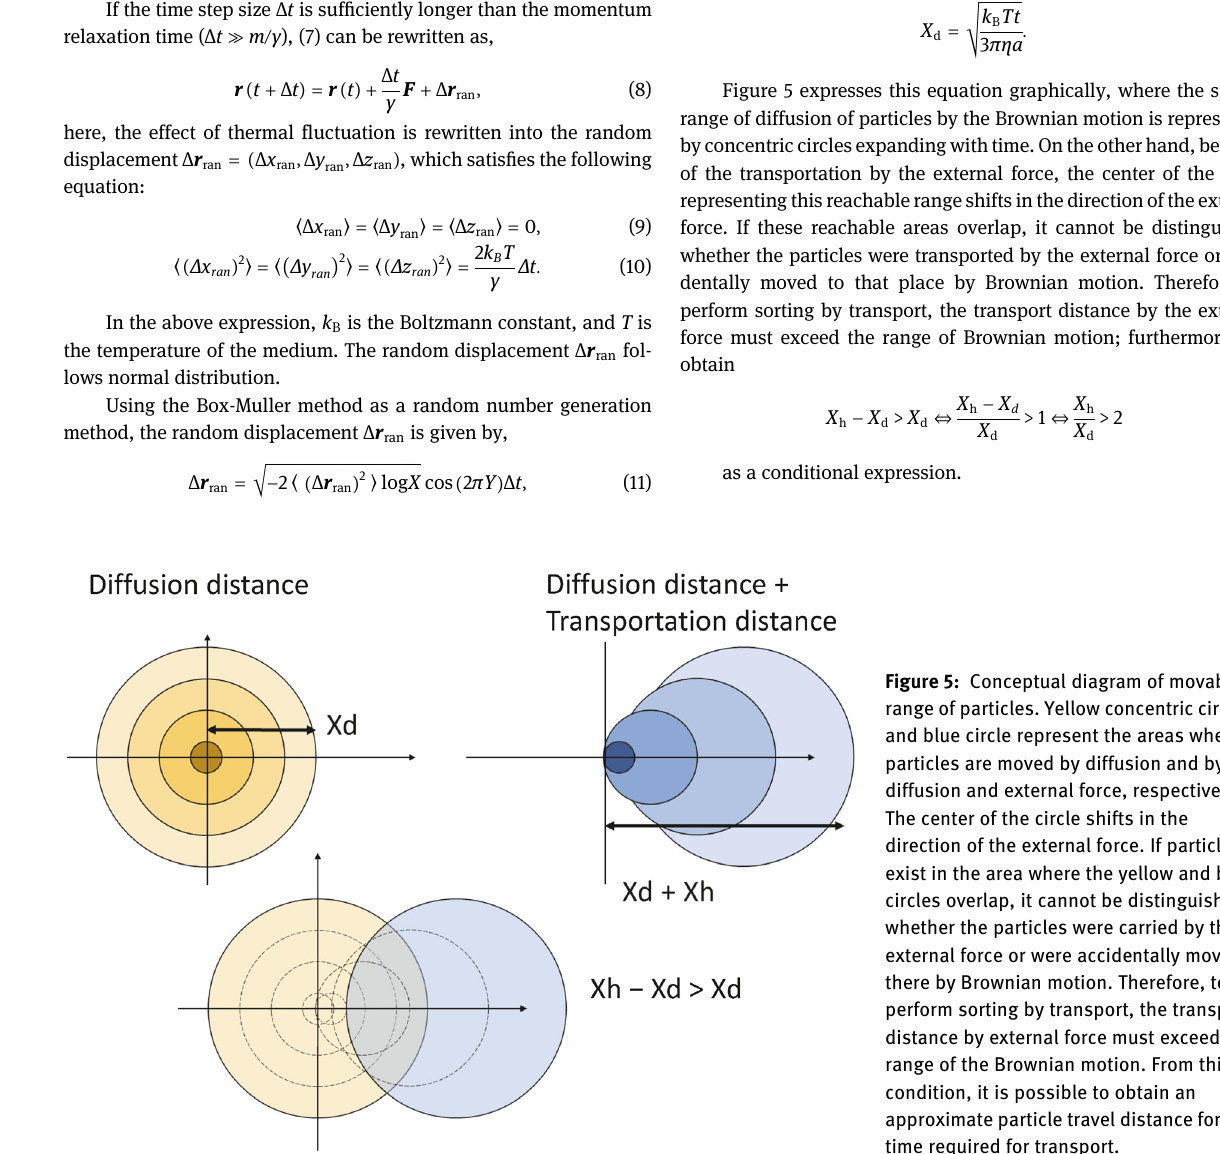
Figure 5: Conceptual diagram of movable range of particles. Yellow concentric circles and blue circle represent the areas where particles are moved by diffusion and by diffusion and external force, respectively. The center of the circle shifts in the direction of the external force. If particles exist in the area where the yellow and blue circles overlap, it cannot be distinguished whether the particles were carried by the external force or were accidentally moved there by Brownian motion. Therefore, to perform sorting by transport, the transport distance by external force must exceed the range of the Brownian motion. From this condition, it is possible to obtain an approximate particle travel distance for the time required for